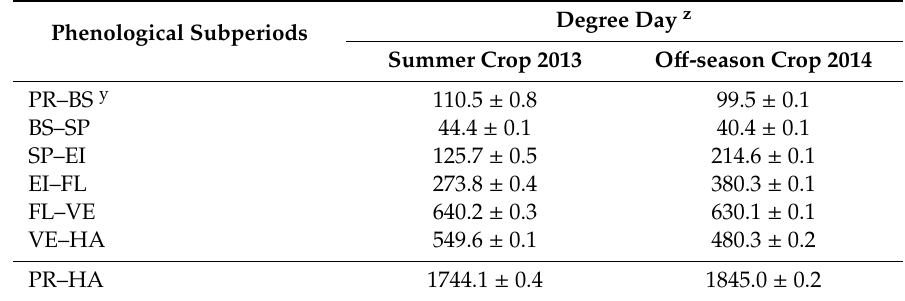
Table 1. Thermal demand in degree days (DD) (mean ± standard deviation) for each phenological phase of ‘BRS Melodia’ grapevine grown in an annual double cropping system in a subtropical region with a summer cropping period in 2013 and a subsequent o ff -season cropping period in 2014.